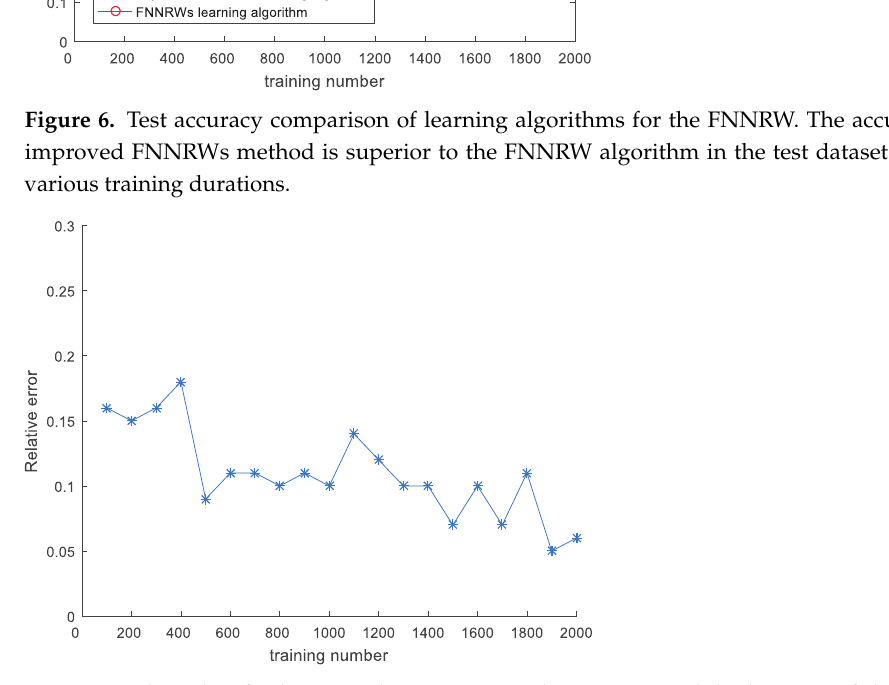
Figure 7. Algorithm for learning the FNNRW’s relative error. While the error of the optimized FNNRW learning algorithm is typically lower than 0.05, the relative error of the FNNRW learning algorithm drops with the number of training repetitions but stays around